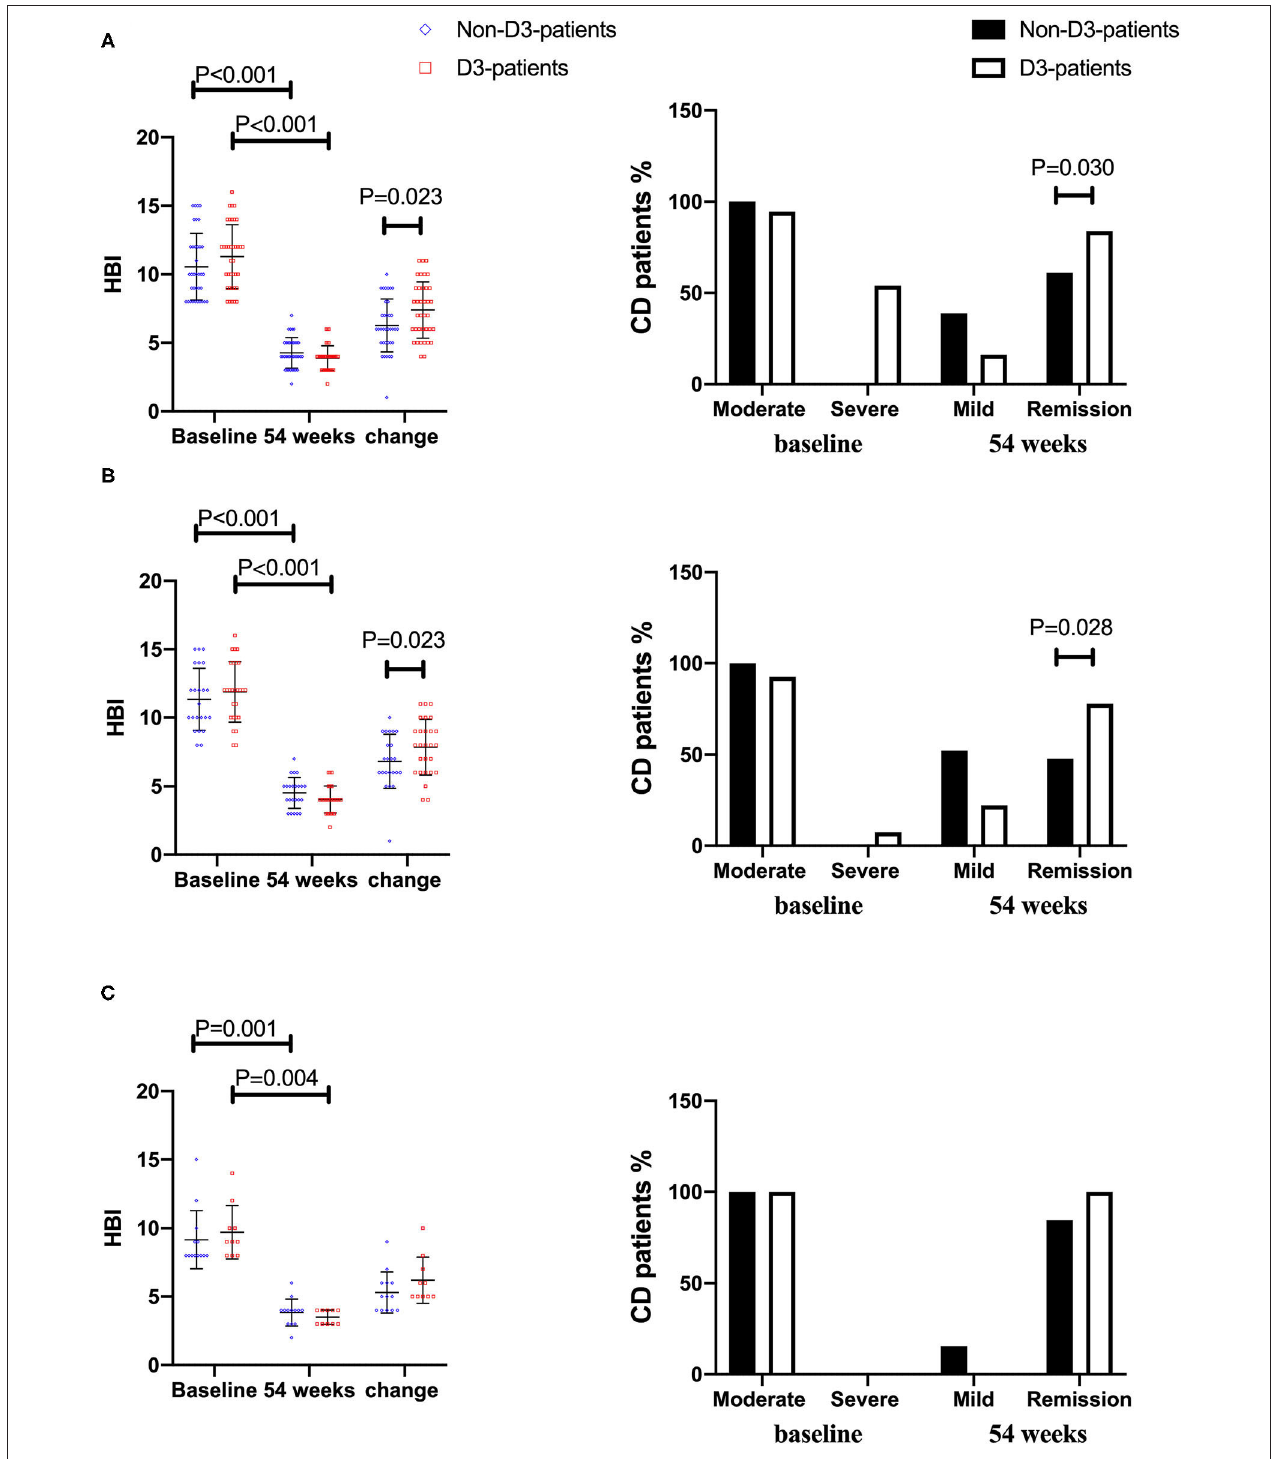
FIGURE 4 | The changes of disease activity between baseline and week 54 in CD patients receiving IFX therapy. (A) In total cohort. (B) In vitD deficient group. (C) In vitD non-deficient group.